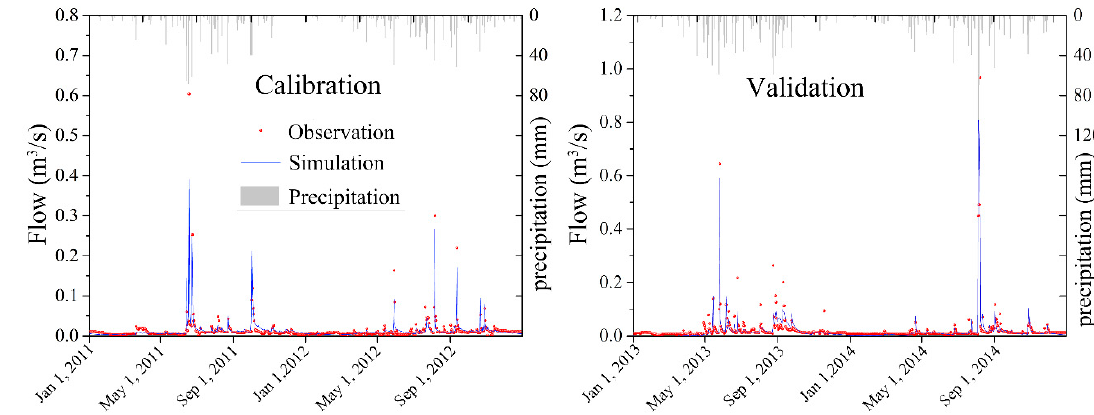
Figure 5. Pareto sets achieved by the multi-objective calibration. The left part is for the continuous modeling, where green, blue, and red dots represent solutions those that achieved four, five, and six criteria of the HSEXP statistics, respectively. The right part is for the event-based modeling, where green dots represent all the Pareto solutions. The original MATLAB figure files (Pareto front-continuous scenario.fig and Pareto front-event-based scenario.fig) are provided as Supplementary Materials.